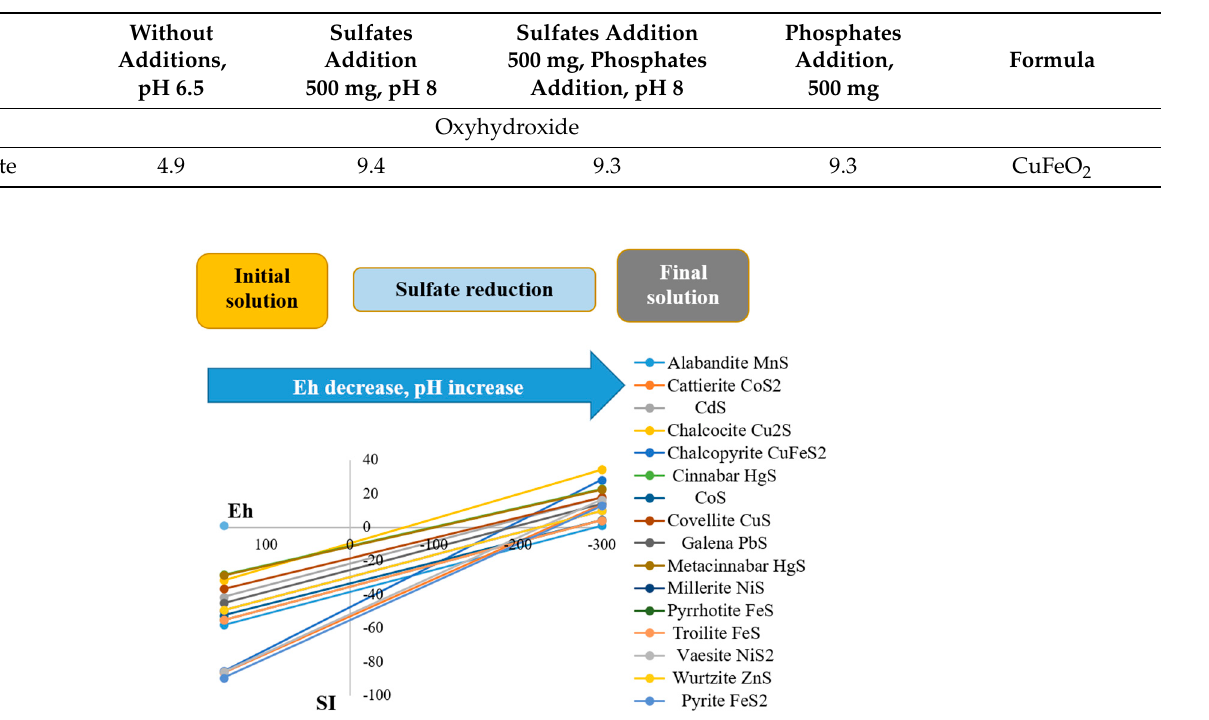
Figure 5. The results of solid mineral phases saturation index (SI) calculation under sulfate reduction